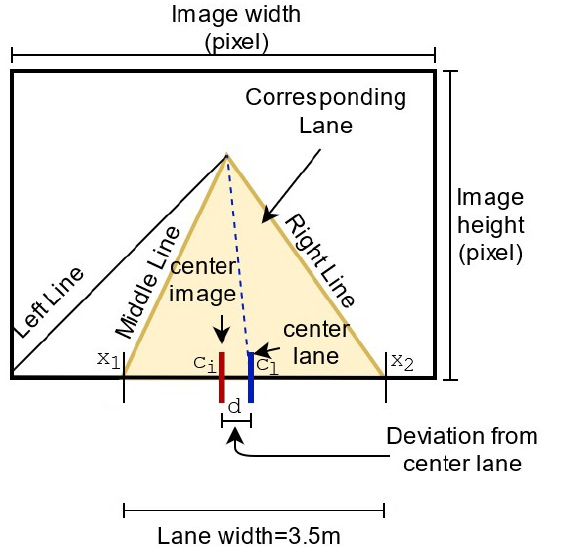
Figure 6. Description of how the deviation distance between the center of vehicle and middle lane is obtained.